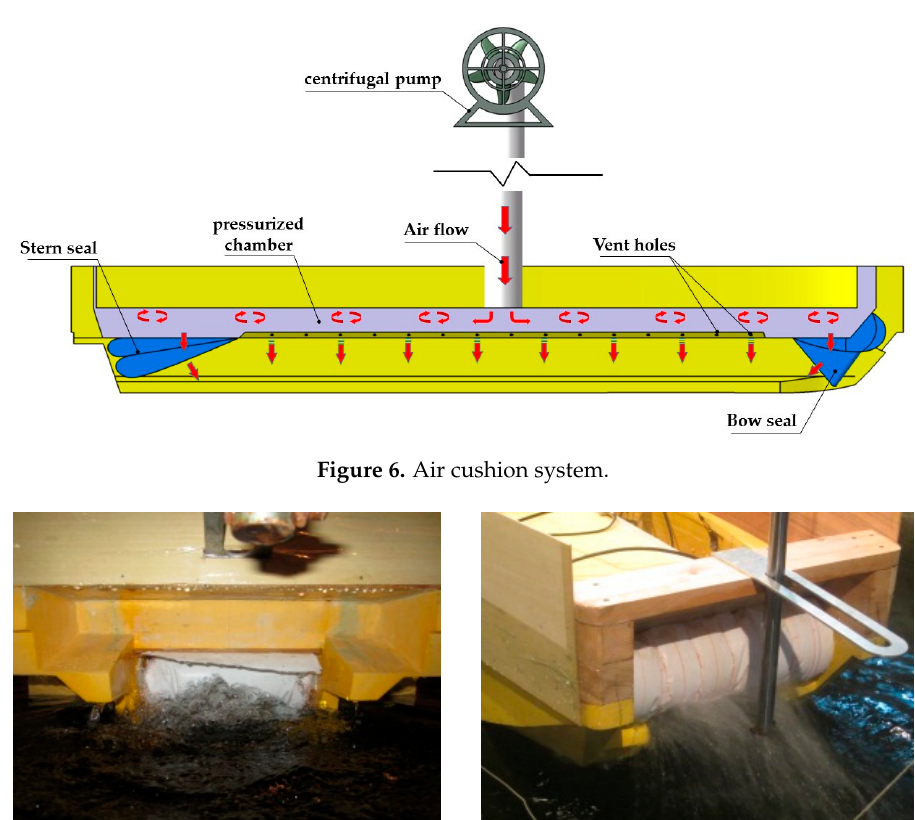
Figure 7. Bow seal and stern seals.